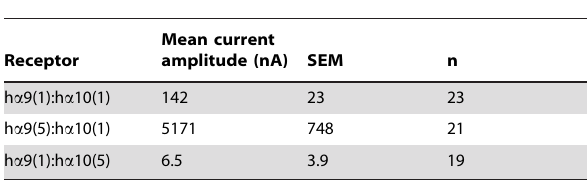
Table 2. Comparison of the functional expression of receptors upon co-injection of different ratios of cRNA for specific subunit. a